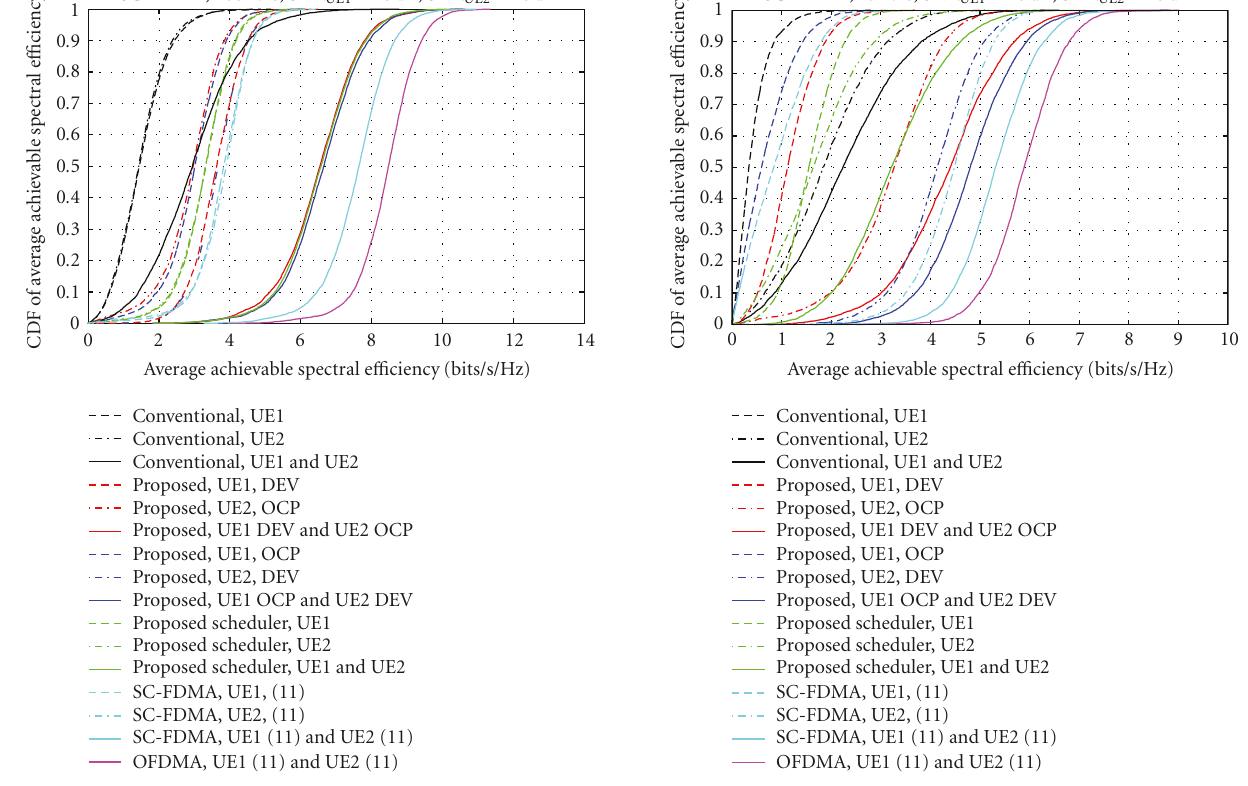
Figure 8: Parameter setting is the same with Figure 6 but with unequal average received SNR for the UEs: SNR UE1 = 0dB and SNR UE2 = 10dB; β =